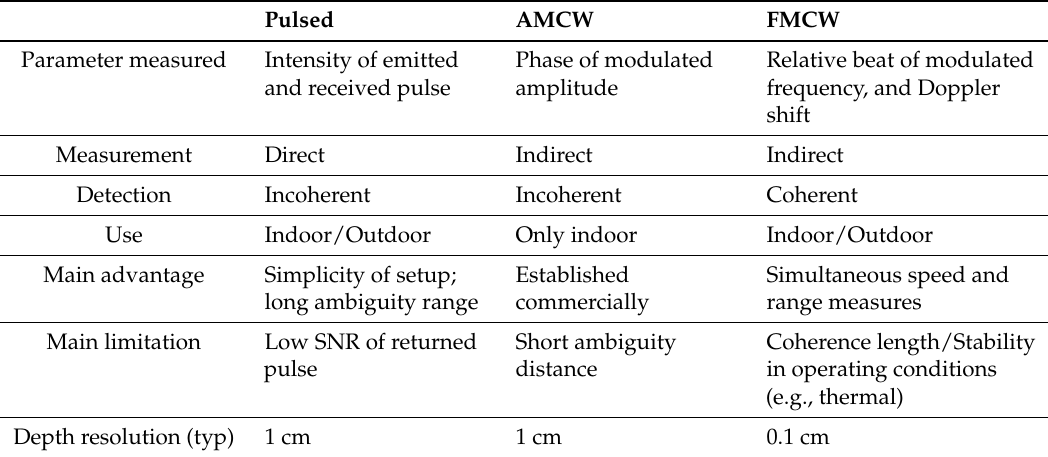
Table 1. Summary of working